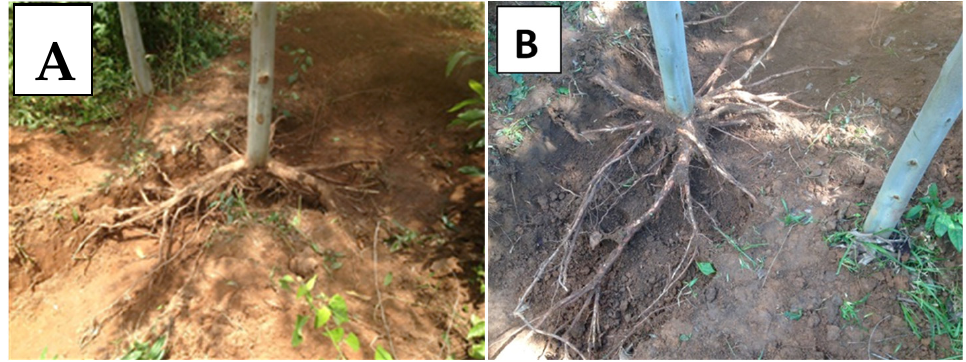
Figure 3. Typical root system of a two-year-old Eucalyptus camaldulensis tree in monoculture ( A ) and intercropping ( B ).